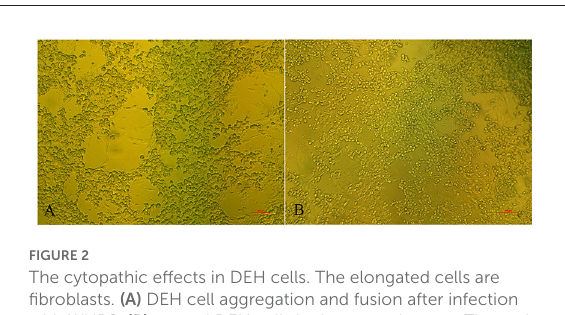
FIGURE2 The cytopathic effects in DEH cells. The elongated cells are fibroblasts. (A) DEH cell aggregation and fusion after infection with WHRS; (B) normal DEH cells in the control group. The scale bar is 100 µ